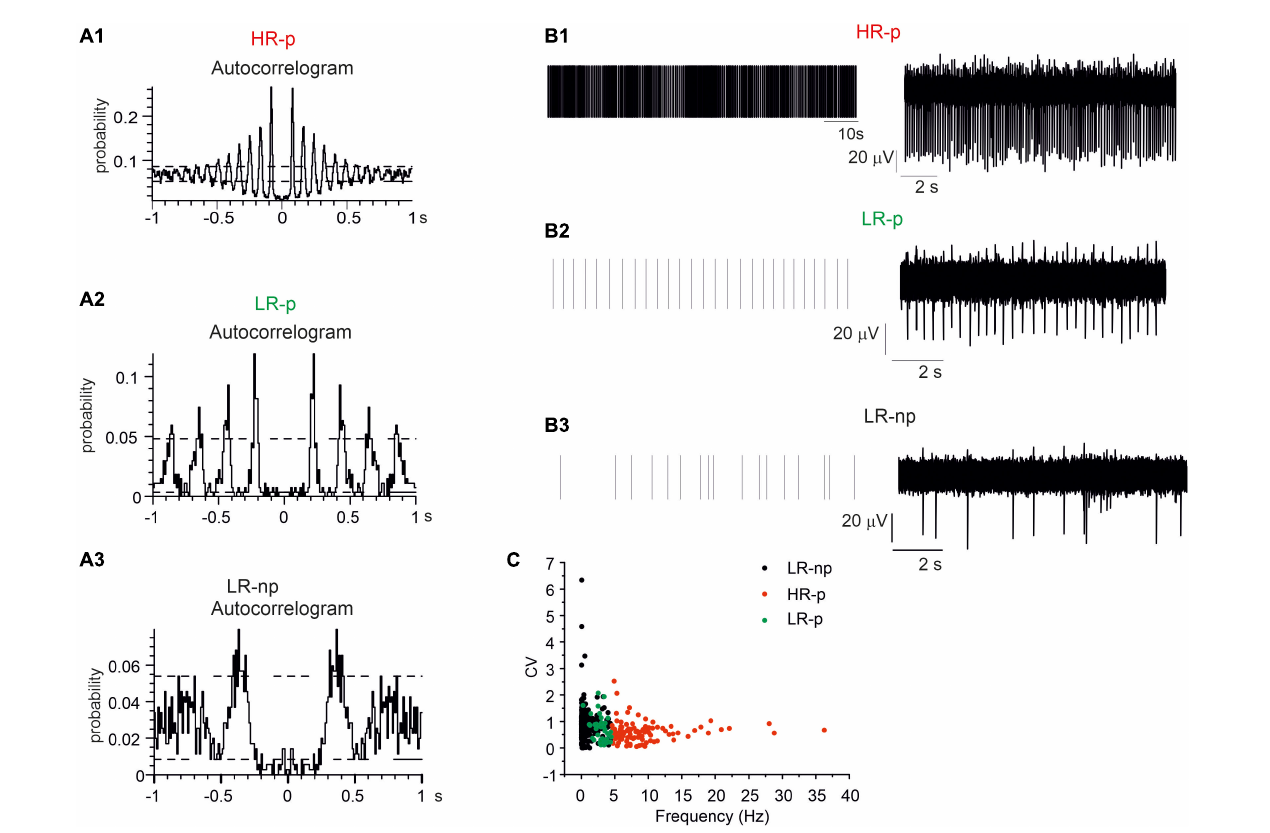
FIGURE6 Identification of different midbrain neurons on the basis of their autocorrelograms. Representative autocorrelograms are shown, respectively, for: (A1) high-rate pacemaking neurons, (A2) low-rate pacemaking neurons, (A3) non-pacemaking neurons. (B1–B3) Raster plots and corresponding traces for a representative high-rate pacemaking neuron, low-rate pacemaking neurons and non-pacemaking neuron. (C) Scatter plot of firing rate vs. CV (coefficient of variation) evaluated by dividing the standard deviation of the inter-spike interval (ISI). The plot shows three different clusters of data corresponding to the three different populations low-rate non-pacemaking, High-Rate pacemaking, and low-rate pacemaking (LR-np, HR-p, and